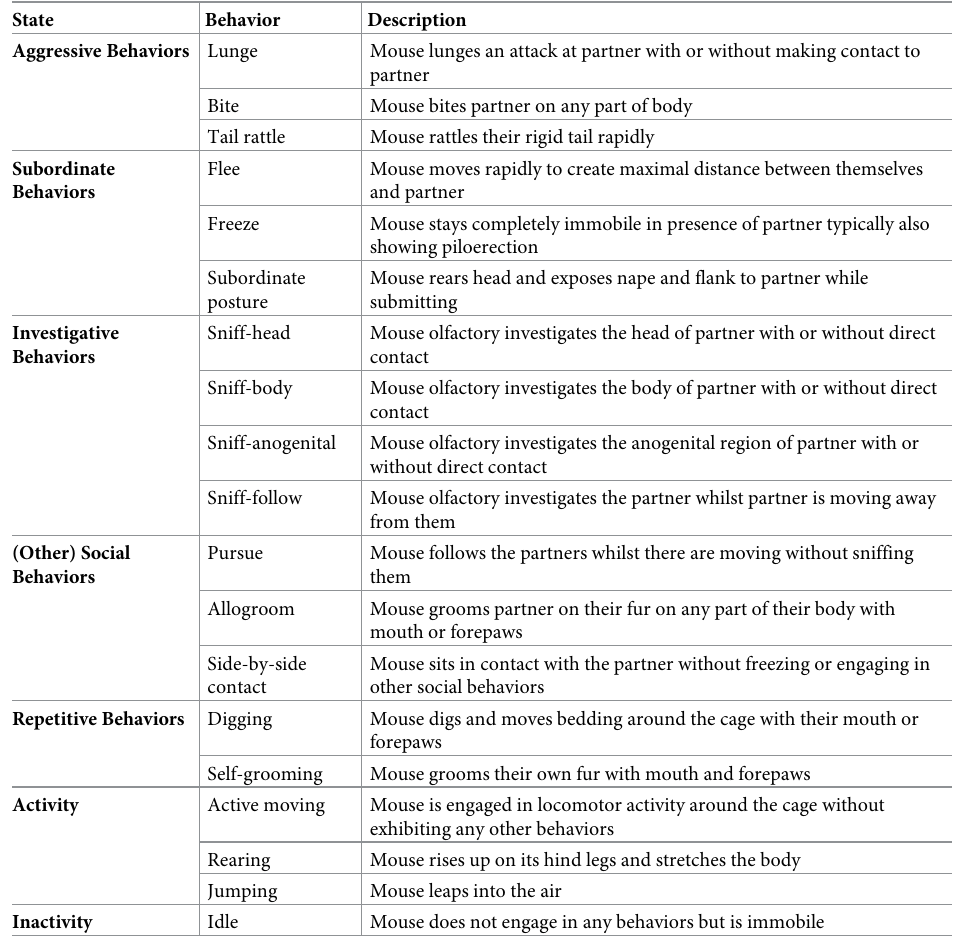
Table 1. Behavioral ethogram and categorization of